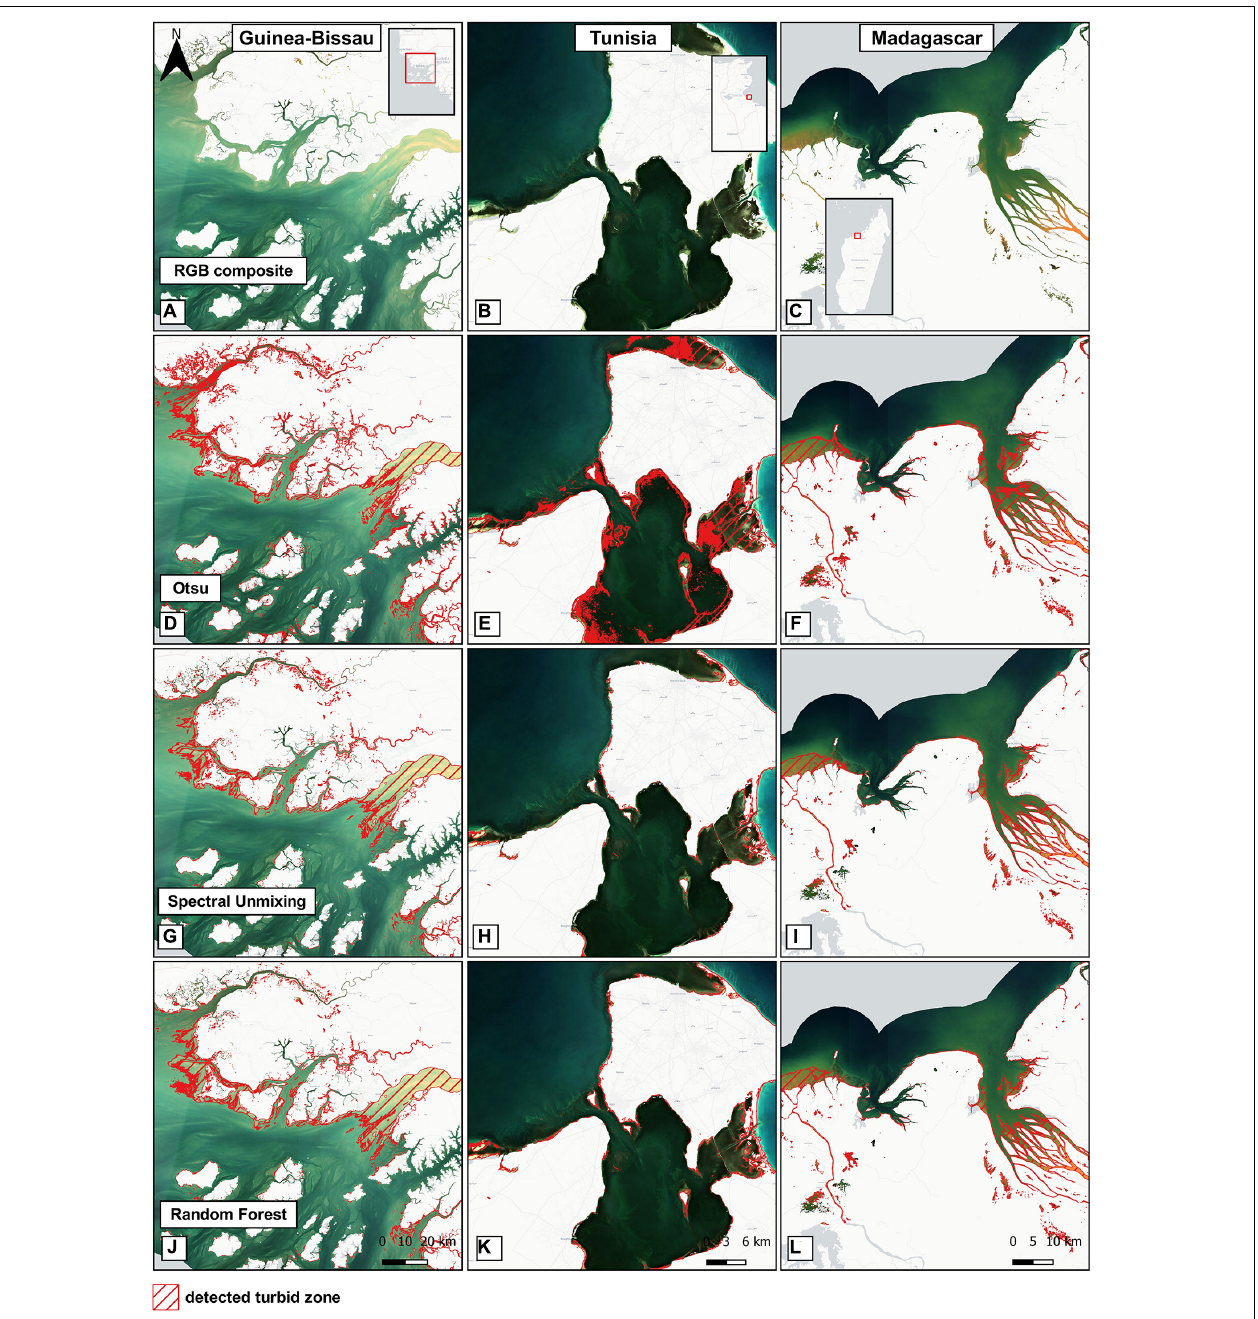
FIGURE 4 | Subsets of the synthesized S2 L2A RGB composite of (A) Guinea-Bissau; (B) Tunisia; and (C) Madagascar study regions; (D–F) RGB composites with turbid zone detected by Otsu’s separation method on ND(B4/B2) raster; (G–I) RGB composites with turbid zone detected by spectral unmixing on B2–B5 composite; (J–L) RGB composites with turbid zone detected by Random Forest classification (base map by CartoDB).